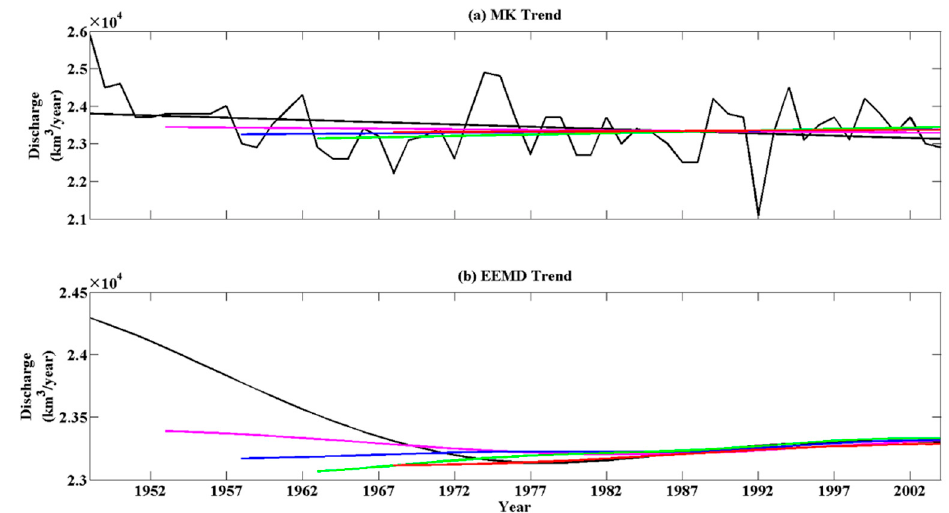
Figure 7. Same as Figure 6, but the trends calculated based on global discharge data with the same ending time (2004), but different starting years of 1948, 1953, 1958, 1963, 1968, and 1973. The estimated trends are shown in ( a ) for the MK method and ( b ) for the EEMD method.